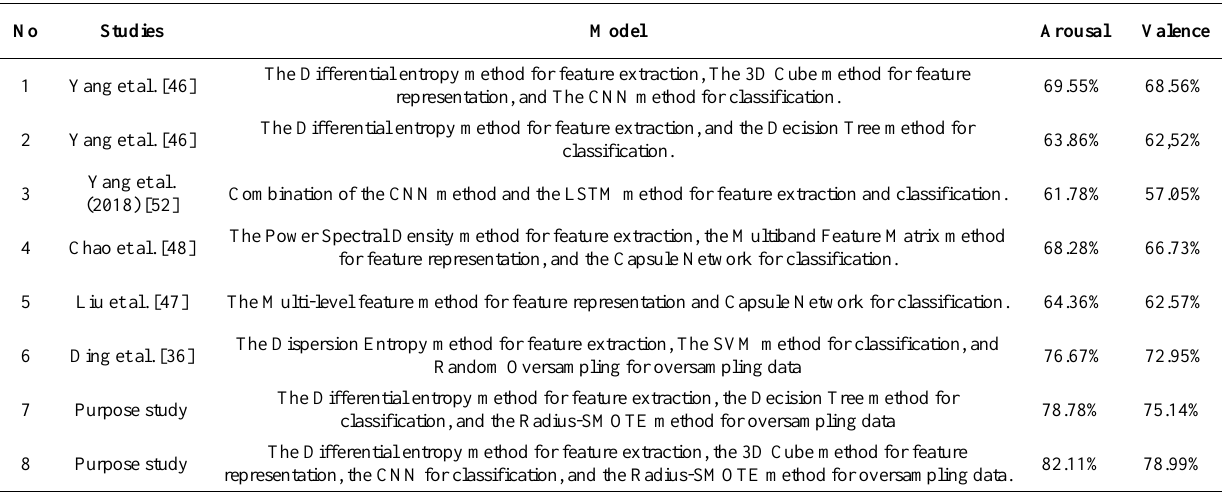
Figure 13. Comparison of valence accuracy for using Decision Tree and with or without the Radius SMOTE method The Radius SMOTE method can improve recognizing valence emotions. However, some participants, such as ID s09, s10, s14, s15, and s32, did not experience an increase because of these data without oversampling process. In general, using Radius-SMOTE to oversampling on the DEAP dataset can improve emotion recognition accuracy. This conclusion indicates that the imbalanced data conditions in the DEAP dataset can reduce the accuracy of emotion recognition. Furthermore, the accuracy results obtained from this study are compared with several others, as shown in Table 4. Table 4. Comparison of emotion recognition accuracy in several